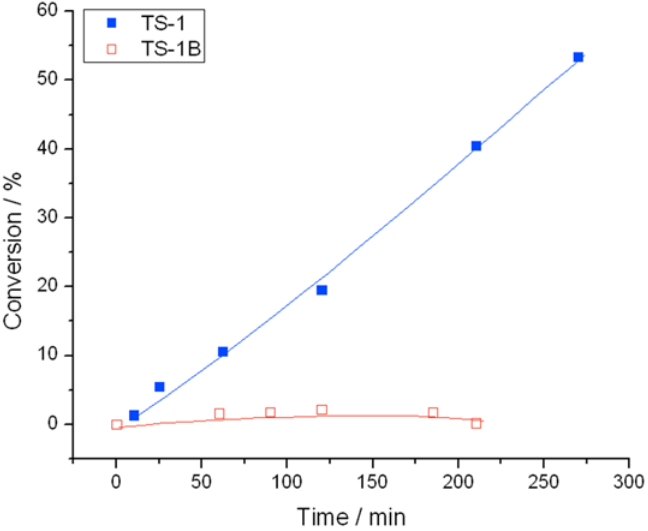
Figure 5. Conversion versus time for H 2 O 2 decomposition at 60 °C over TS-1 and TS-1B. In contrast, H 2 O 2 decomposition activity is almost completely suppressed following NH 4 HF 2